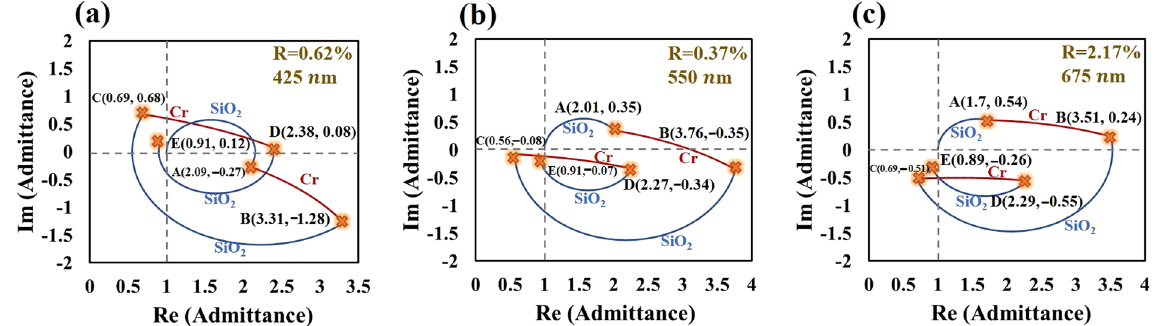
Figure 3. NAD loci of Air/SiO 2 (80 nm)/Cr(6 nm)/SiO 2 (88 nm)/Cr(6 nm)/SiO 2 (80 nm)/Air system at wavelengths of 425 nm, 550 nm, and 675 nm, shown as blue (SiO 2 ) and red (Cr)